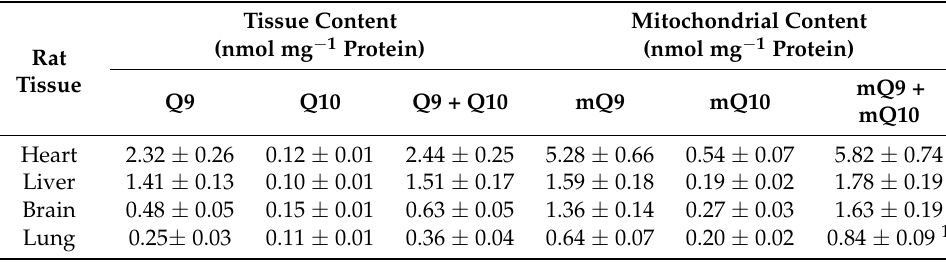
Table 1. Q9, Q10, and total Q (Q9 + Q10) content in different rat tissues and their